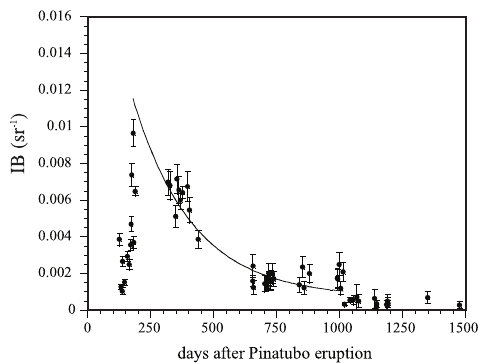
Fig. 3. Time evolution of integrated backscattering IB for the period 1991-1995. Also reported is the exponentially decreasing function fi tted to the data.